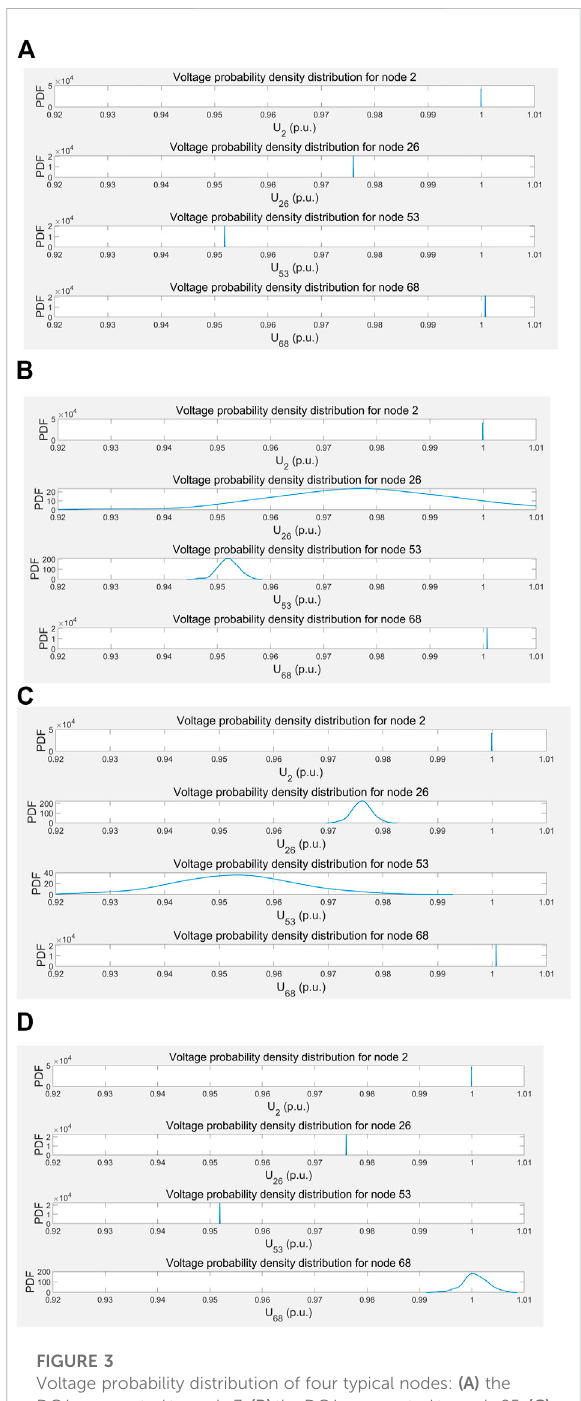
FIGURE 3 Voltage probability distribution of four typical nodes: (A) the DGisconnectedtonode3, (B) theDGisconnectedtonode25, (C) the DG is connected to node 52, (D) the DG is connected to node